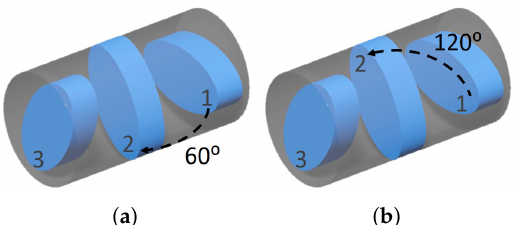
Figure 3. Dielectric rod with 3-fold twist symmetry. Rotation of the ellipses with ( a ) right handedness and ( b ) left